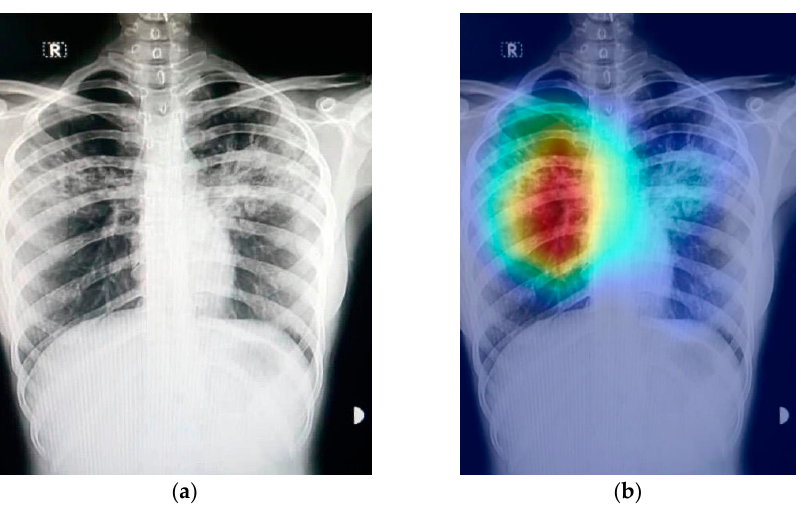
Figure 9. Grad-CAM technique results on the COVID-19 X-ray image: ( a ) COVID-19 X-ray image; ( b ) Grad-CAM of the image.